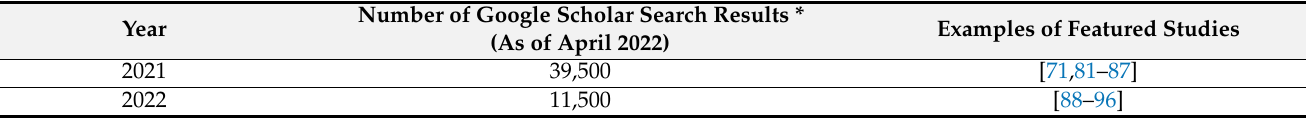
Examples of Featured